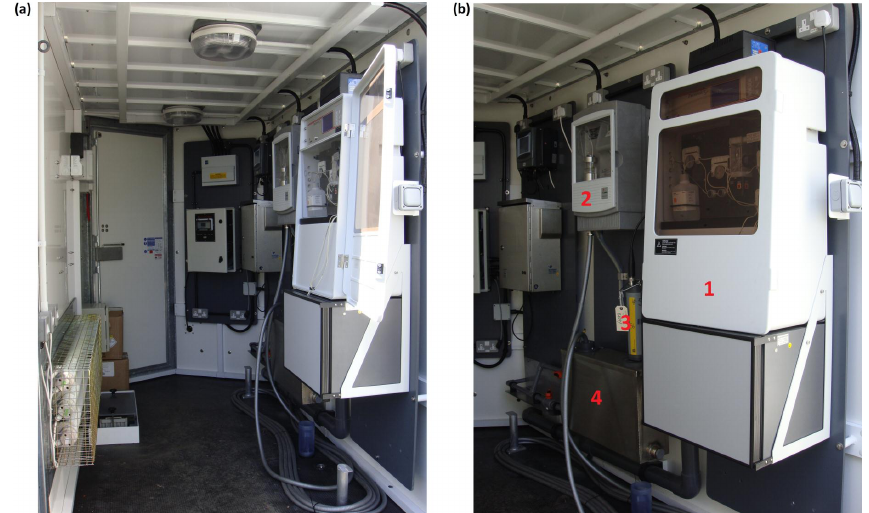
Figure 4 2 Fig. 4. An internal view of the monitoring station on The Cut taken on 22 April 2010 (SU91397866): (a) the layout of the station, with all 3 monitoring equipment housed on the right-hand side and the heater on the left-hand side, and (b) close up of the monitoring equipment: (1) Hach Lange Phosphax, (2) Hach Lange Sigmtax, (3) YSI Multi-parameter Sonde and (4) the flow cell where water is pumped to from the river and then samples are extracted for